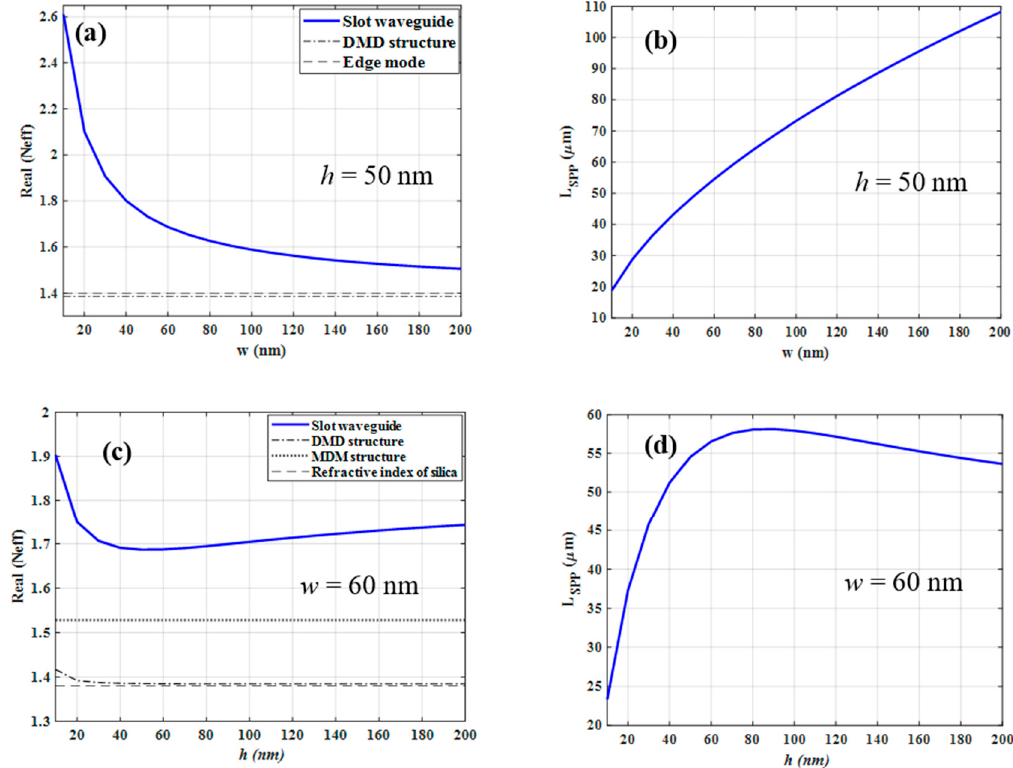
Figure 5. ( a ) The variation of effective mode index ( N ef f ) of the fundamental mode of a symmetric PSWG versus the slot width ( w ) when the gold thickness is fixed to 50 nm. ( b ) The propagation